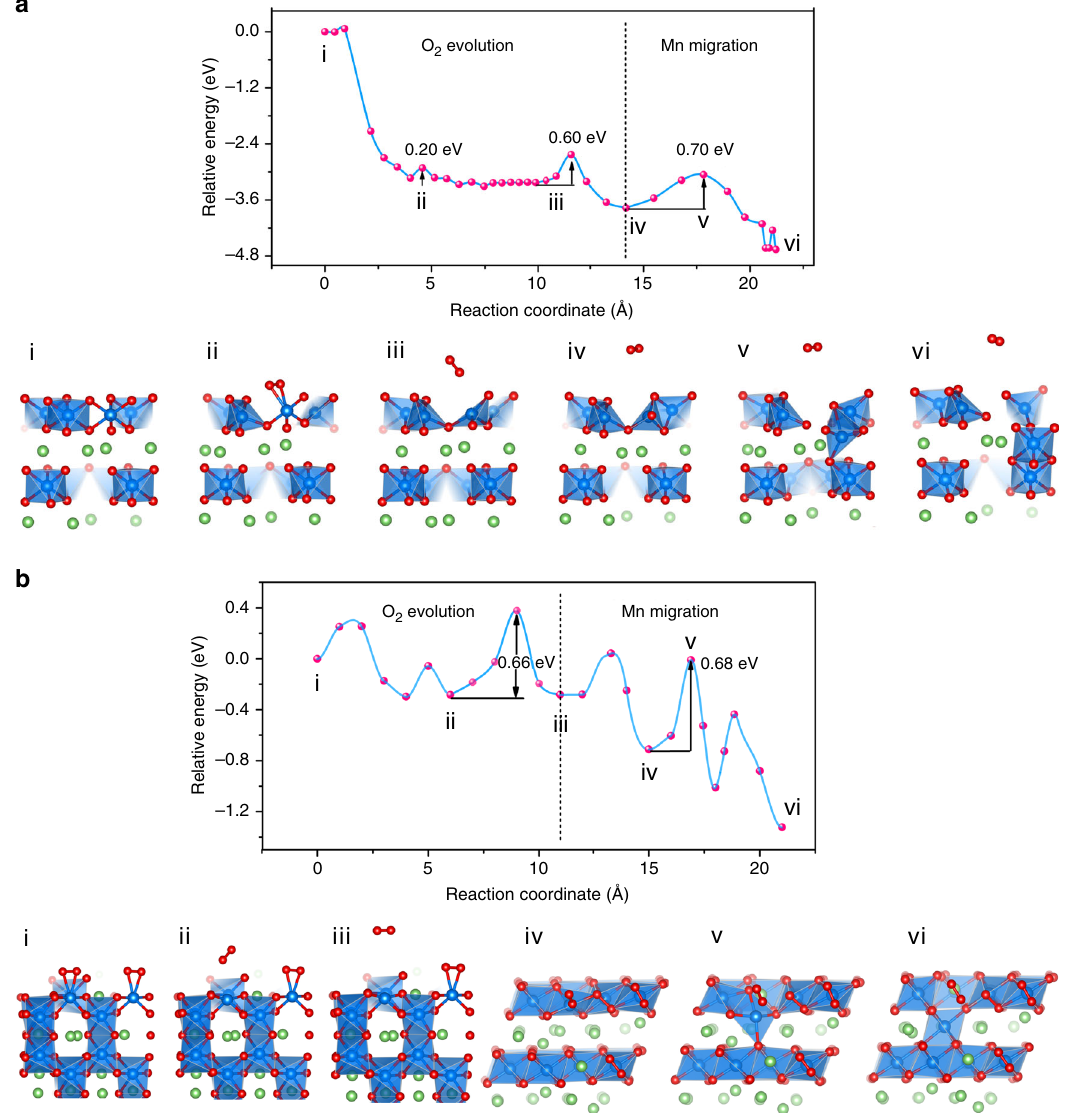
Fig. 2 Minimum energy path (MEP) plot for O 2 evolution and Mn migration at the surface of Li 2 MnO 3 . a , b MEP plot for O 2 evolution and Mn migration from the TM layer to the Li layer (upper) in the (001) ( a ) and (010) ( b ) surfaces, and the corresponding structures of some intermediates and transition states (below). All slabs in ( a ) and the fi rst three slabs in ( b ) are shown as side views, while the last three slabs in ( b ) are top views to better visualize the Mn migration